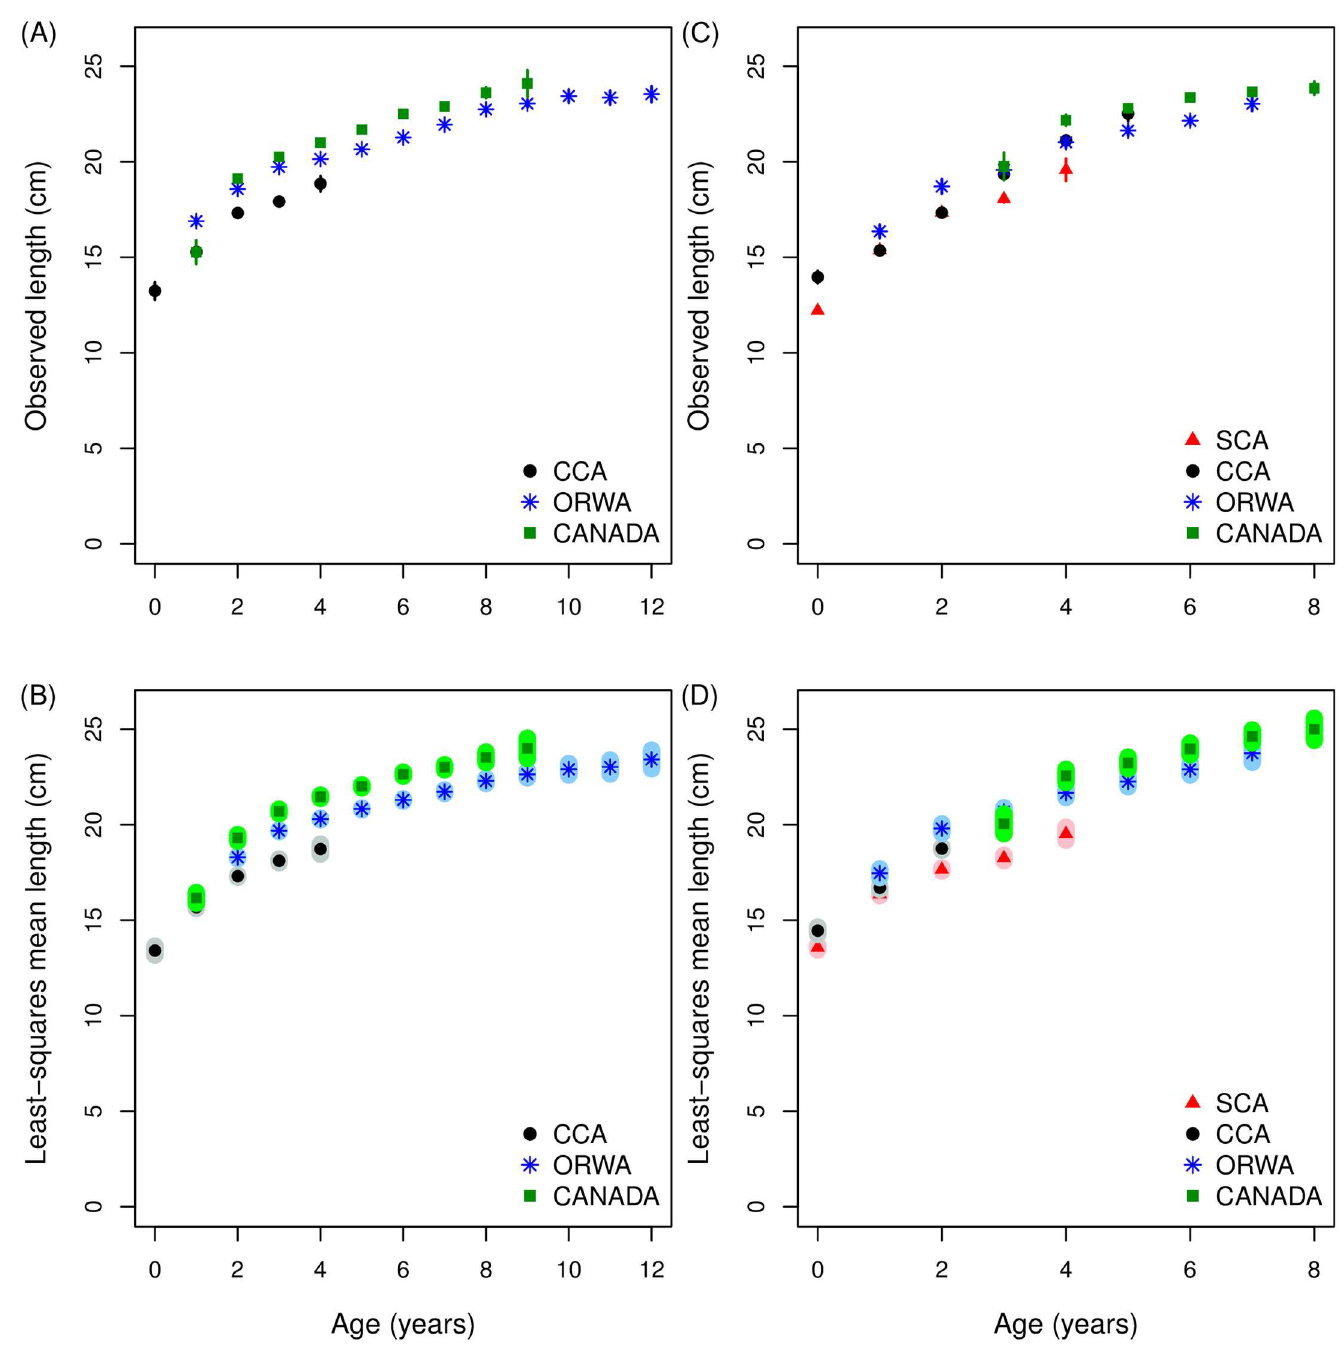
Fig 4. Observed mean length-at-age and least-squares mean length-at-age for quarter 3 (July-September) and quarter 4 (October-December) from 1981–2010. (A) Quarter 3 observed mean length-at-age; and (B) least-squares mean length-at-age for central California (CCA, ● ), the Columbia River basin (ORWA, * ), and Canada(CANADA, ■ ); (C) Quarter 4 observedmean length-at-age; and (D) least-squares mean length-at-age for Southern California (SCA, ▲ ), central California (CCA, ● ), the ColumbiaRiver basin (ORWA, * ), and Canada(CANADA, ■ ) where the error bars in the upper panelsindicate the 95% confidenceintervals of the observations and shadedareas in the lower panelsrepresent 95% confidenceintervals of the